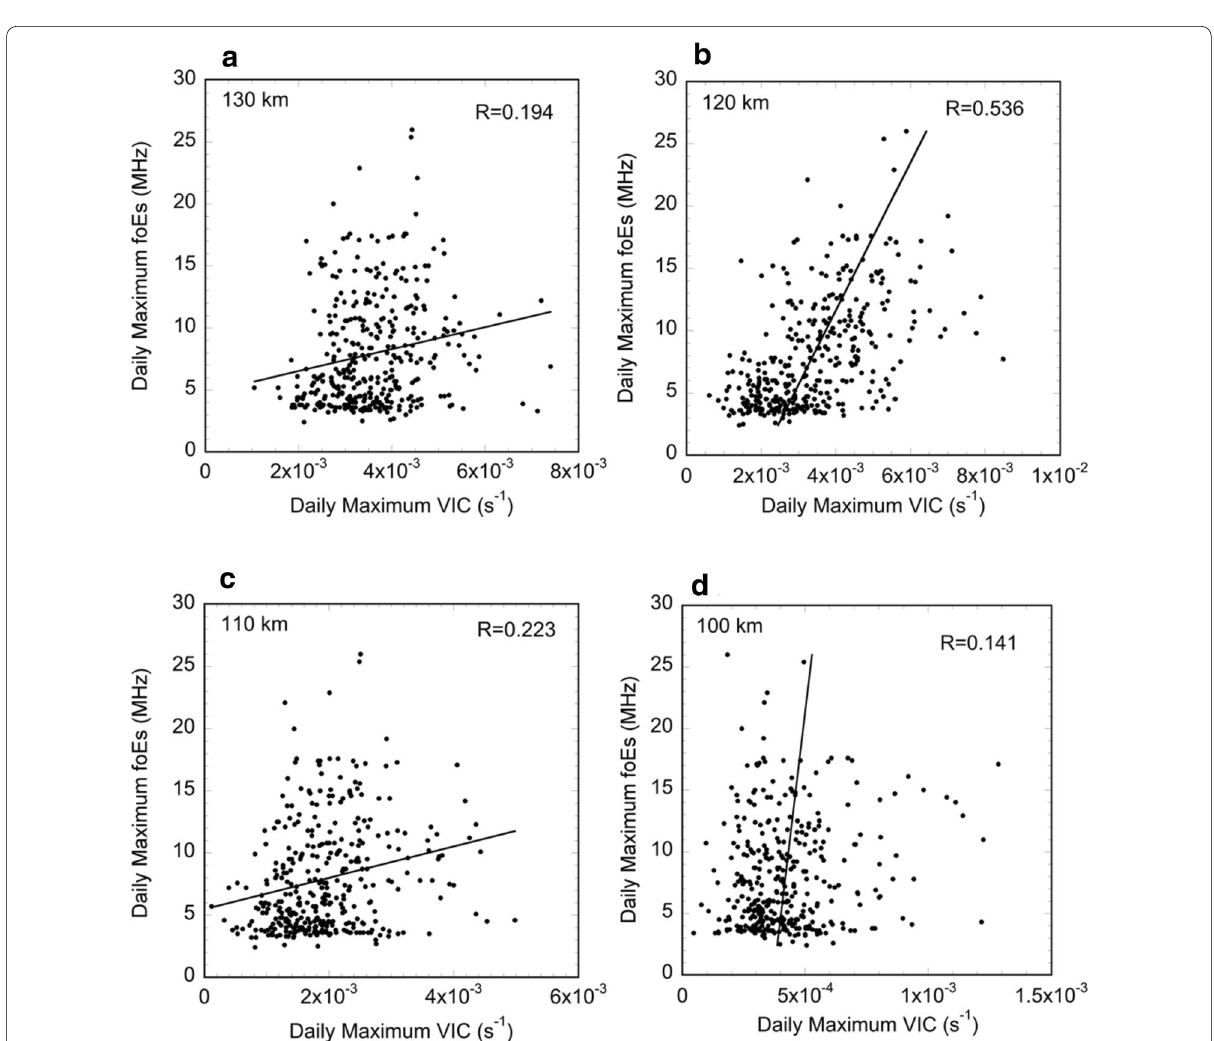
Fig. 7 Correlation coefficients of the daily maximums of foEs and VIC . Scatter plots and correlation coefficients of the daily maximums of foEs and the daily maximums of the vertical ion convergence ( VIC ) are shown at four different altitudes at Kokubunji